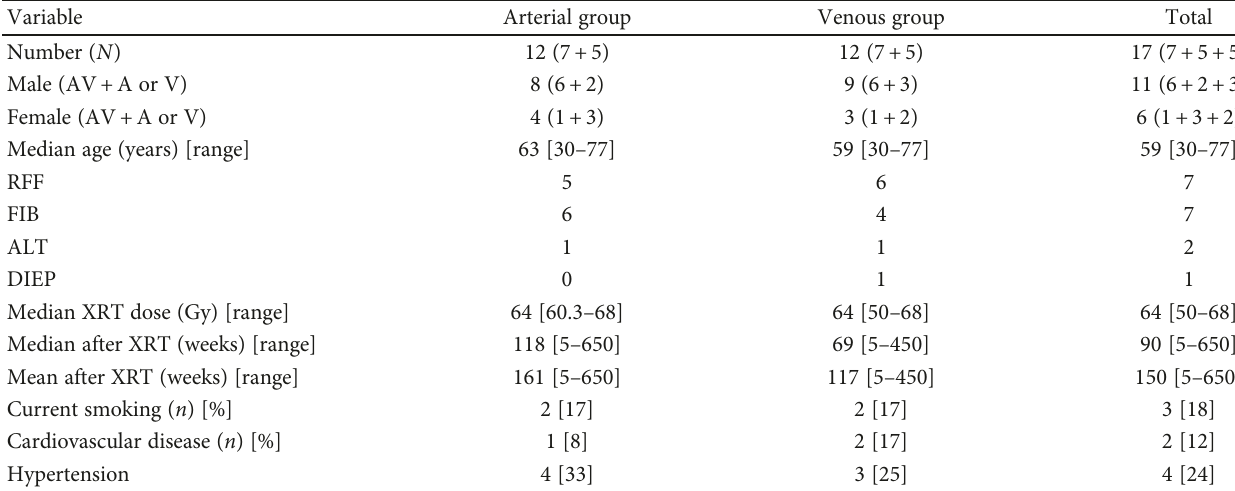
Table 1: Demography of the cohorts. Seven patients participated in both the arterial and the venous groups (AV), 5 only in the arterial group (A), and 5 only in the venous group (V). (XRT =radiotherapy; Gy=gray; RFF=radial forearm fl ap; FIB= fi bular fl ap; ALT=anterior lateral thigh; and DIEP=deep inferior epigastric perforator). Individual patient characteristics are listed in Supplementary Materials (available here).